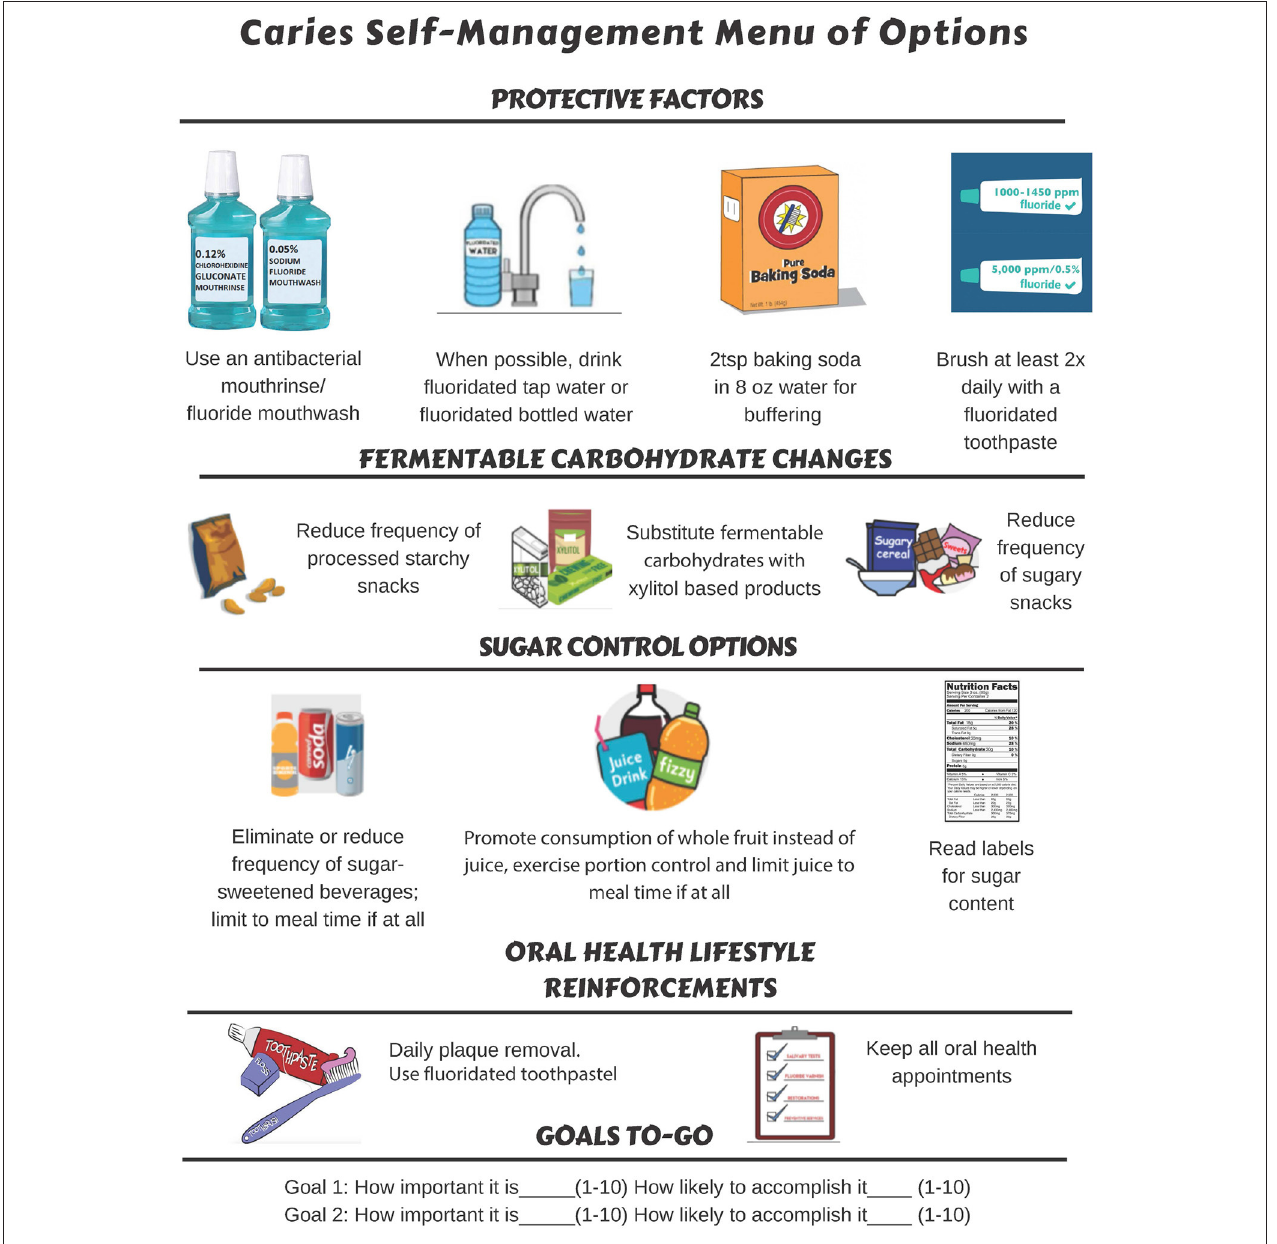
FIGURE 1 | Caries self-management menu of